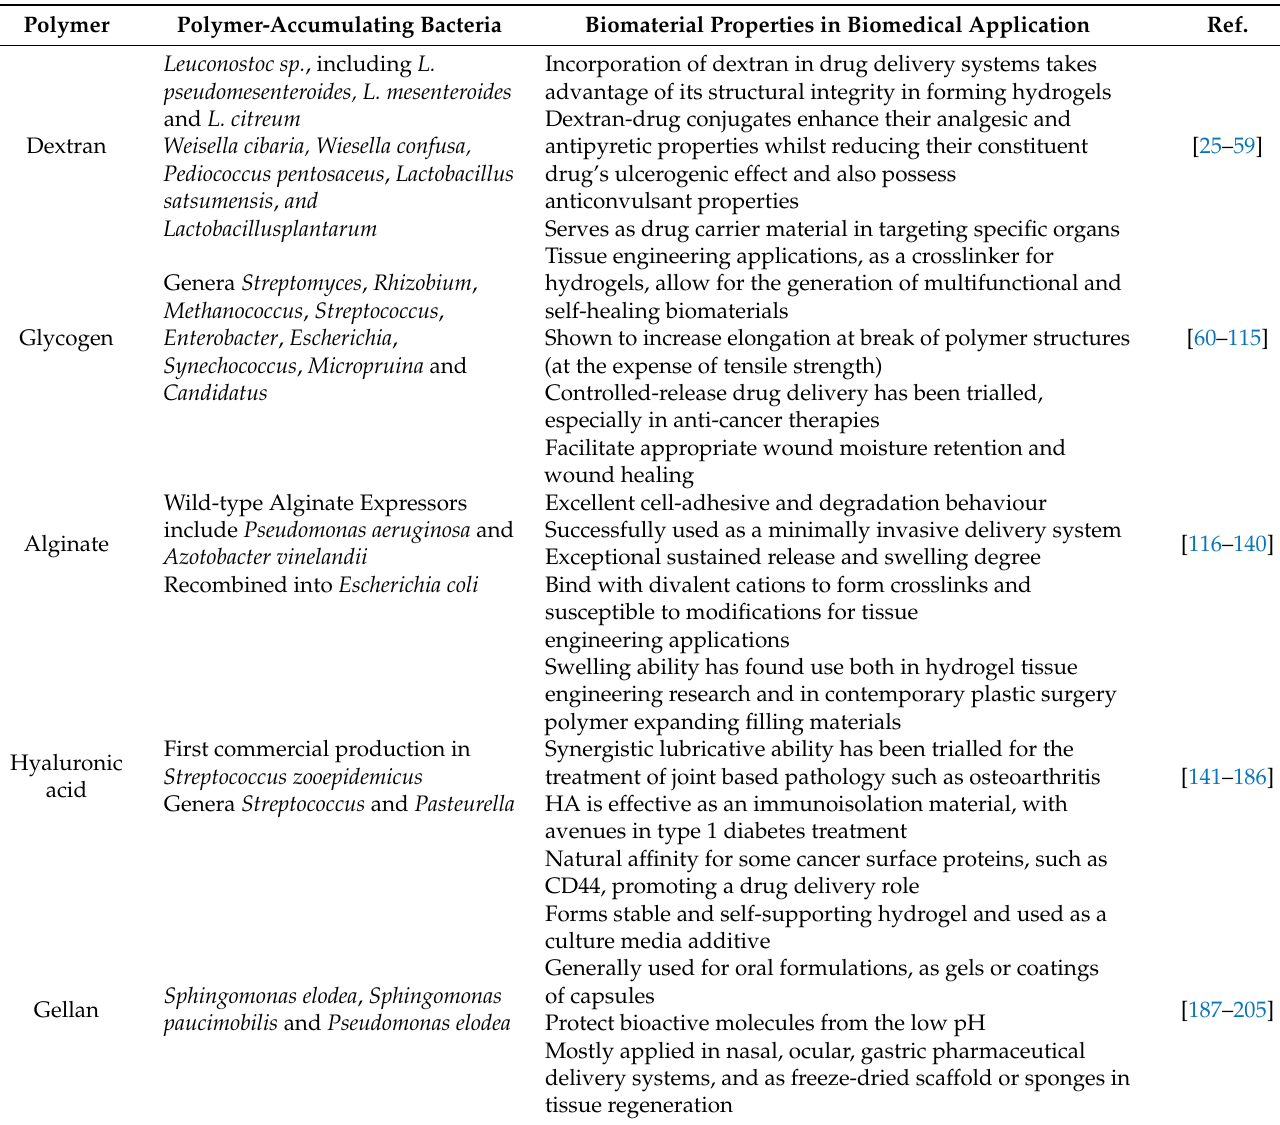
Table 1. Summary Table for Bacteria-Derived